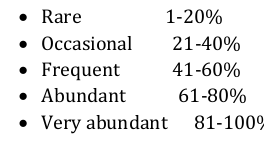
Anagallis arvensis